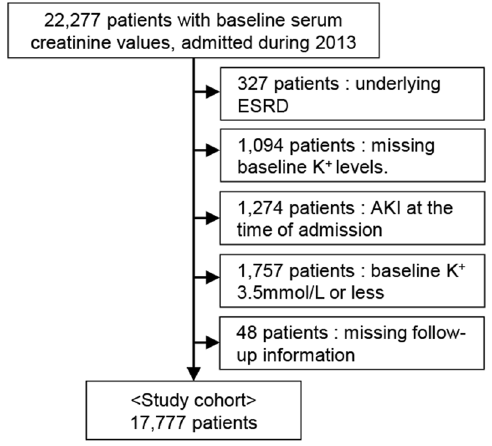
Figure 1. Flow diagram for the study